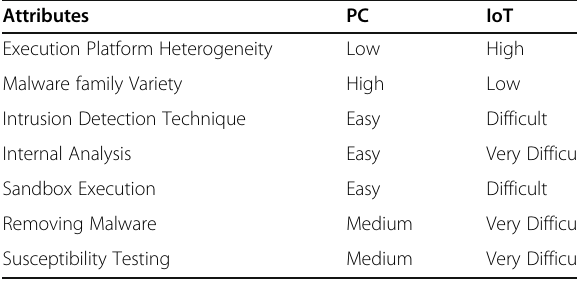
Table 9 Difference the security attributes between computer and